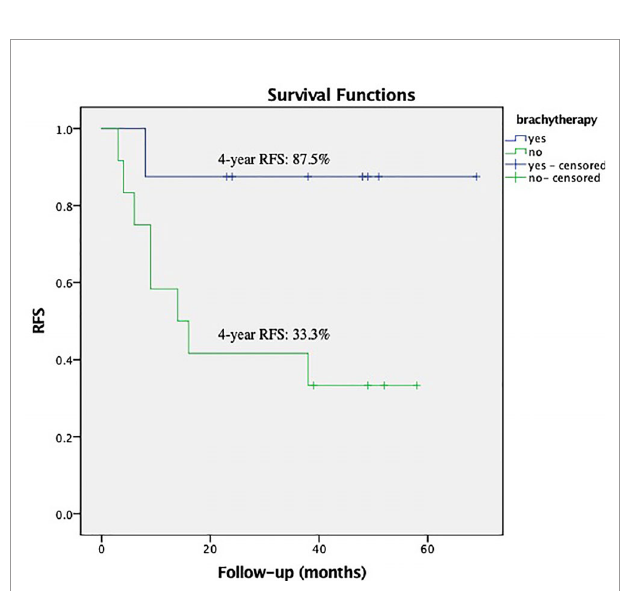
FIGURE 2 | Recurrence Free Survival (RFS) with or without vaginal cuff brachytherapy in patients with a bulky mass that received low external beam radiation therapy dose. The 4-year RFS was 87.5% vs. 33.3%, respectively, P =